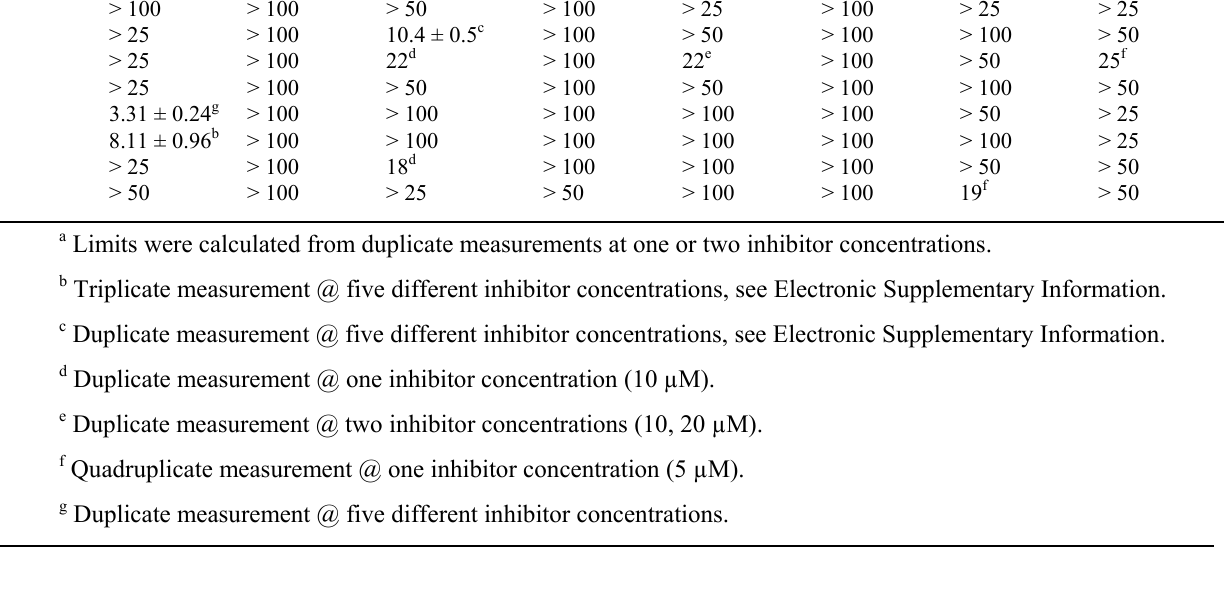
Figure 2. Plot of the steady-state rates versus inhibitor concentration for the inhibition of HLE by compound 5i